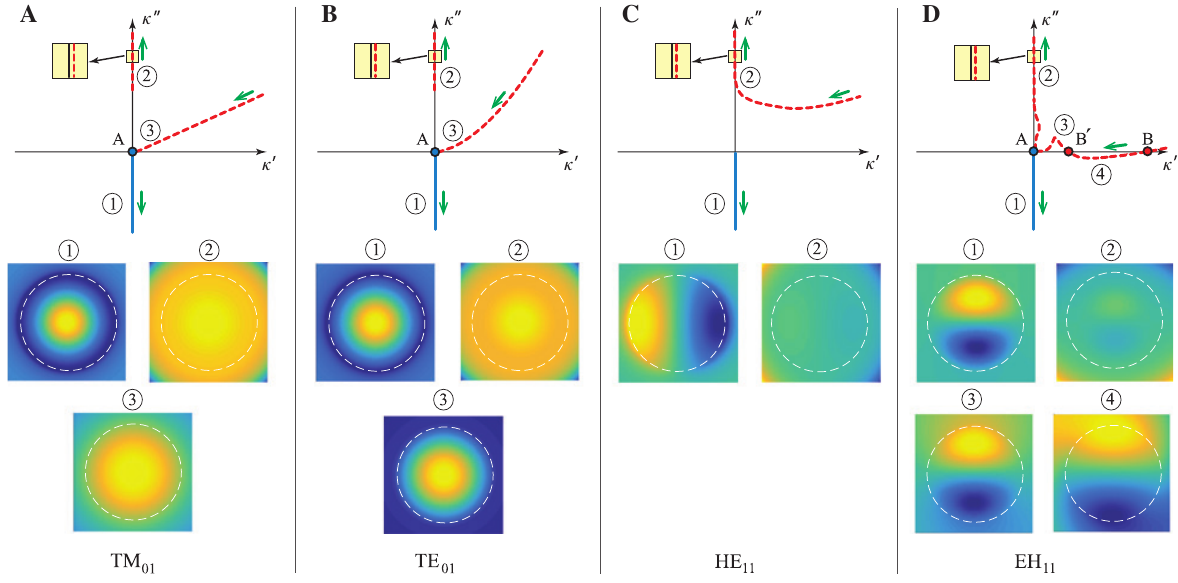
Figure 3: Roots appearance and fields distribution of trapped surface and leaky waves. Roots of dispersion equations in the complex κ ′ − κ ″ plane and the electric and magnetic field patterns of (A) TM HE ( H ), and (D) EH ( E ) modes. The half-planes κ ″ > 0 and κ ″ < 0 correspond to the regions of existence of proper and improper waves, 11 z 11 z respectively. Bold green arrows are directed toward the increasing frequency. The numbers ➀ – ➃ and letters A, B, and B ′ correspond to those depicted in Figure 2. In the plots of electric and magnetic field patterns, the white dashed circles designate the interface between the graphene-coated nanowire and free space. All problem parameters are the same as in Figure